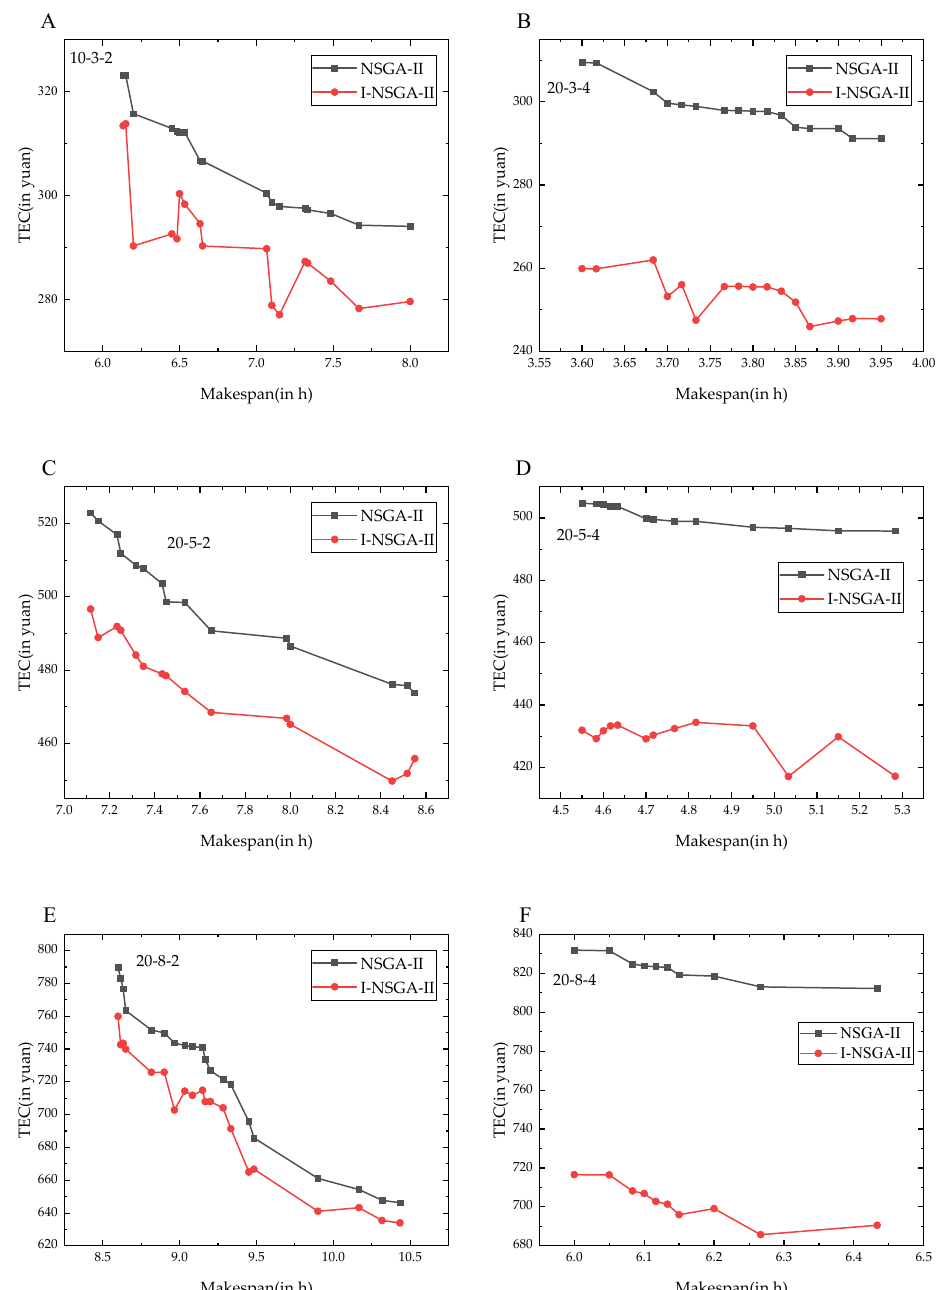
Figure 10. Pareto fronts found by each algorithm for 20-job instances. Figure 11 presents the Pareto fronts found by I-NSGA-II and NSGA-II for large in- stances with 50 jobs. In general, it may be concluded from the figures that the improved algorithm does not achieve ideal results, which shows that there are certain limitations. As the number of workpieces increases while machines used for processing have not increased, the space for right movement operations is reduced. Nevertheless, energy consumption can still be